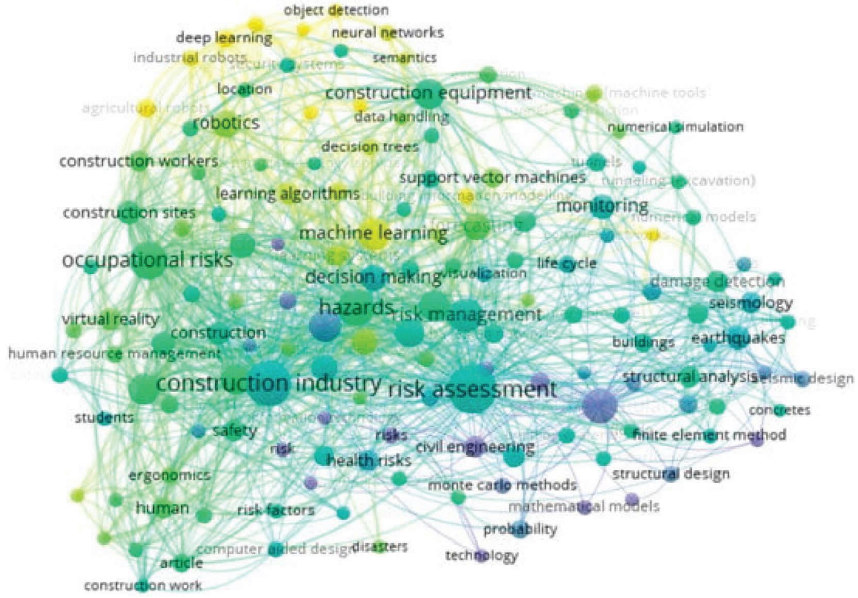
Figure 3: Keyword co-occurrence network